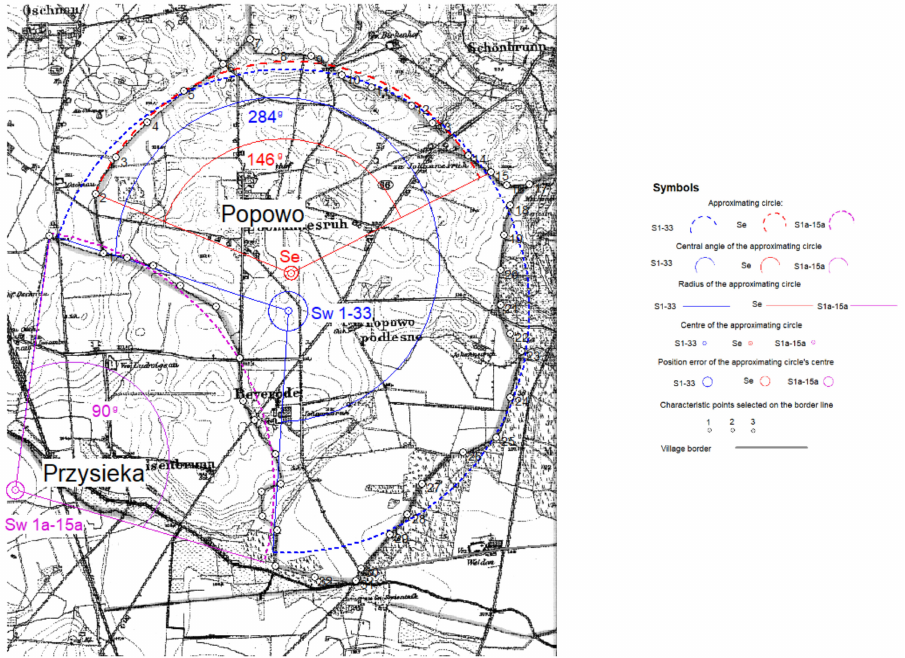
Figure 13. Popowo and Przysieka. Course, position and error of the approximating circle: Popowo: Sw 1—33—approximation of points 1—33, Se—approximation of points 2—15 without point 7; Przysieka: Sw 1a—15a—approximation of points 1a—15a.